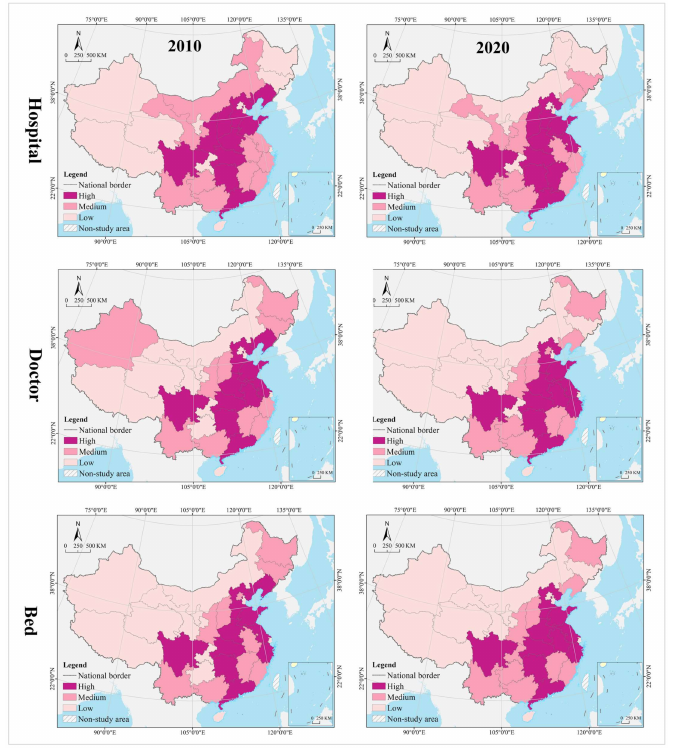
Figure 4. Distribution pattern of medical